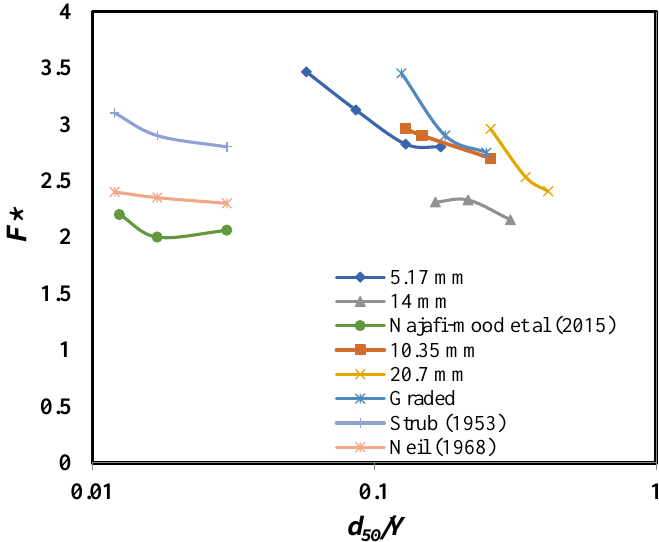
Figure 10. Comparison between results of current study with other researchers.